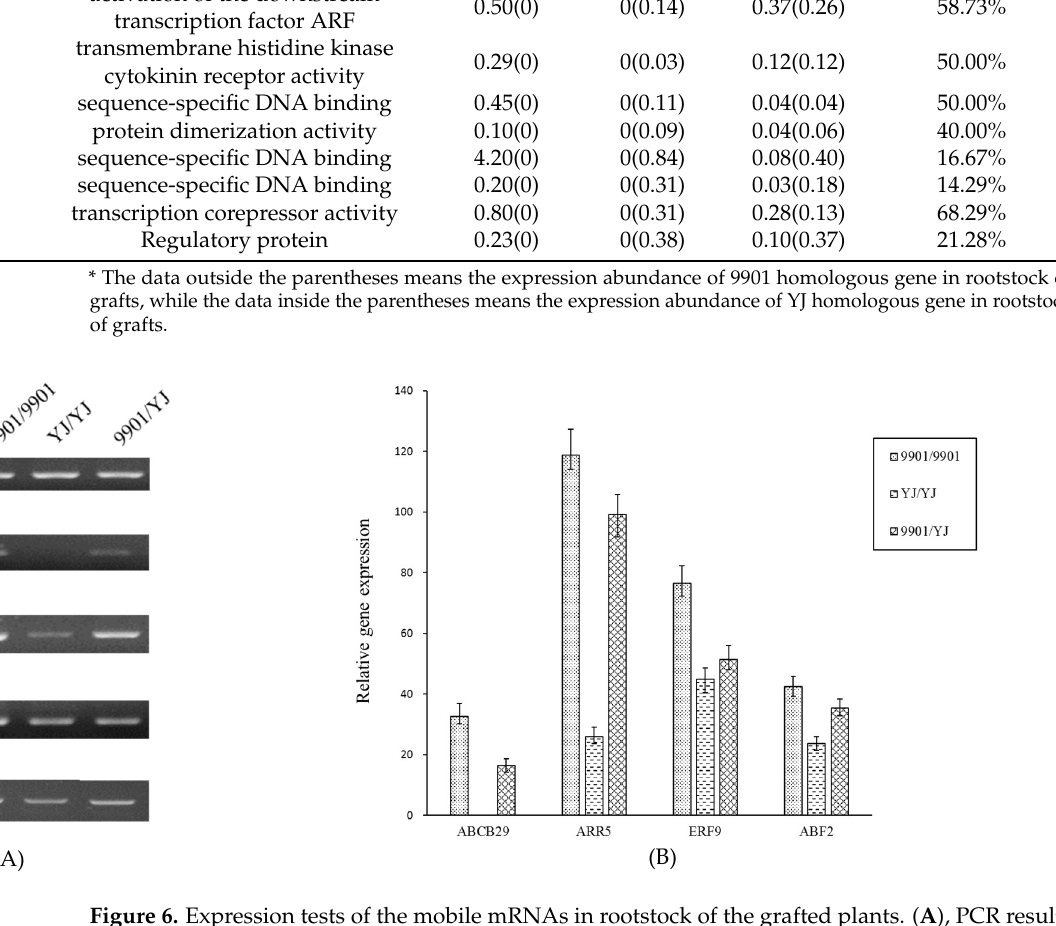
Table 5. The mobile mRNAs involved in the plant hormone signal transduction pathway.